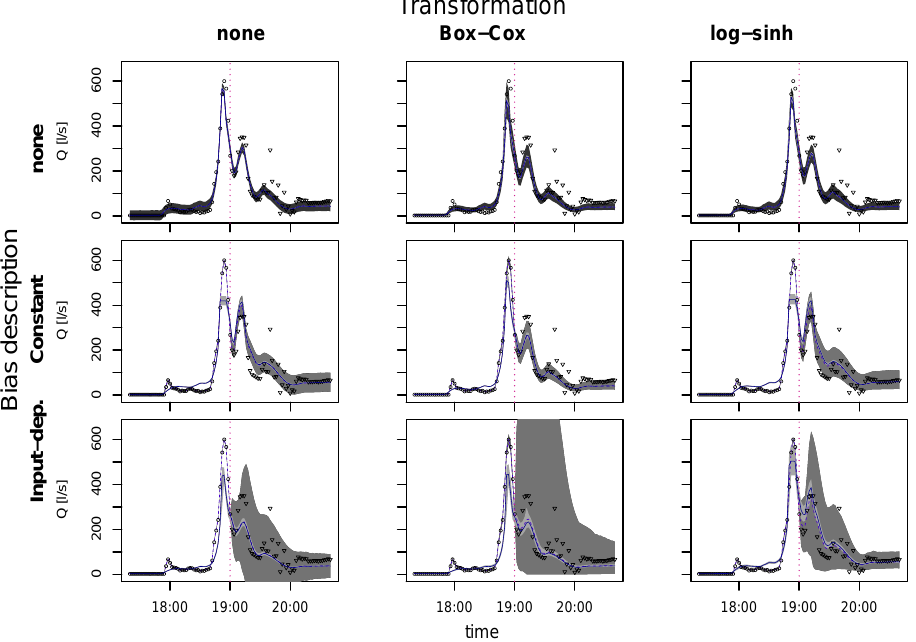
Fig. 3. The 95% credible intervals for flow predictions for the transition phase obtained with different assumptions on error distribution. The vertical dotted line divides the calibration layout (past) from the validation layout (future). The solid line is the deterministic model output with the optimized parameter set, whereas the dashed line is the bias-corrected output representing our best estimation of the true system response. Observed output of the system is represented by circles and triangles. Triangles were only used to validate the model. Colors of the credibility intervals: deterministic model predictions (light gray), predictions of the real system output (intermediate gray), predictions of new observations (dark gray). When considering bias, the contribution of uncorrelated observation errors E to total uncertainty becomes very small ( . 1Ls − 1 ) and therefore is not visible at this scale. Consequently, the credibility intervals for the system output ( g − 1 ( ˜ y M + B M ) ) and the observations ( g − 1 ( ˜ y M + B M + E ) ) are almost identical and overlap.